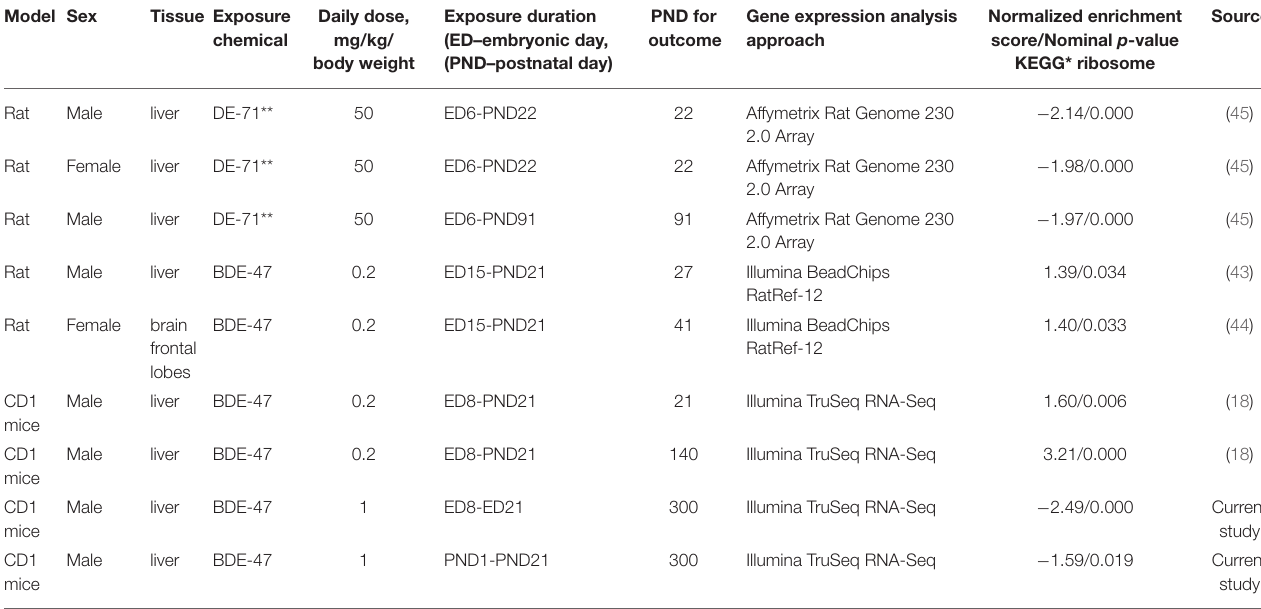
TABLE 2 | Gene set enrichment analysis (GSEA) of ribosome dataset in transcriptomic studies of PBDE effect in rodents and details of experimental design of these studies. Model